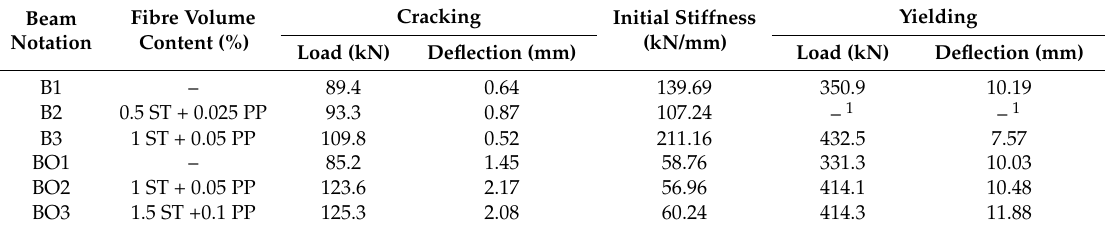
Table 4. Load-deflection response parameters of beams at cracking and yielding loads.